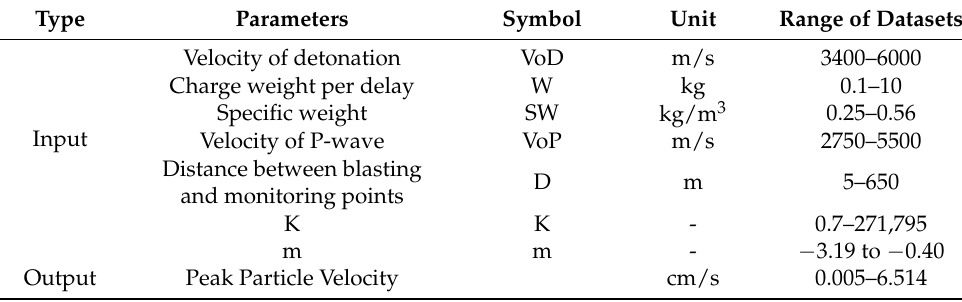
Table 2. Input values for types of rock.